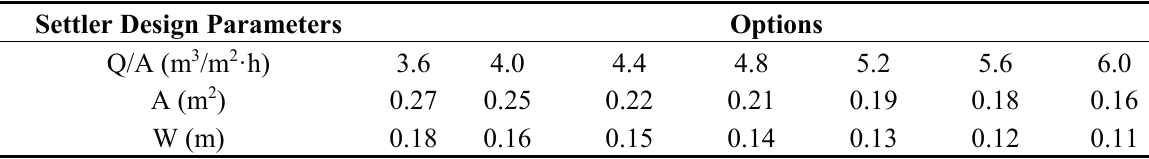
Table 4. Different options for settler design: widths, ratio Q/A (m 3 /m 2 ·h) and settling areas. Settler Design